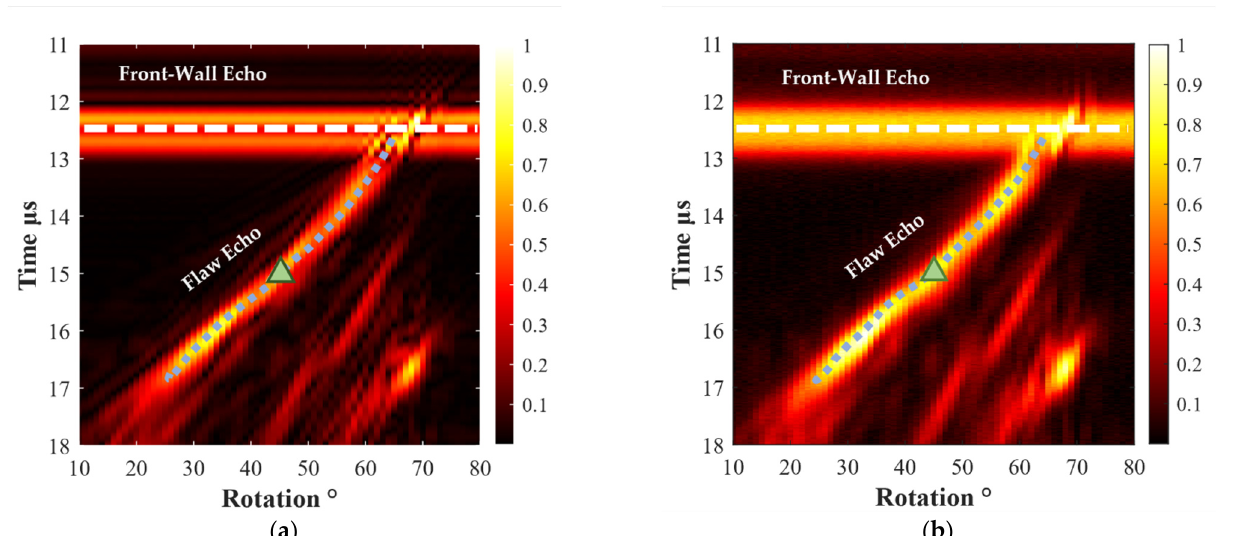
Figure 7. B scan image: ( a ) simulation; ( b ) experiment. The width of the notch was 0.2 mm.